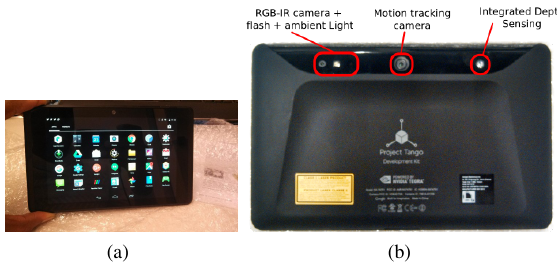
Figure 1: Google Tango tablet. (a) Interface similar to a classic Android tablet. (b) Embedded sensors for 3D perception.